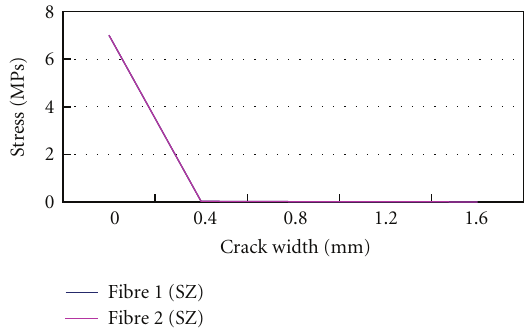
Figure 15: Characteristic length comparison. < concrete with 2 kg short fiber < concrete with 2 kg long